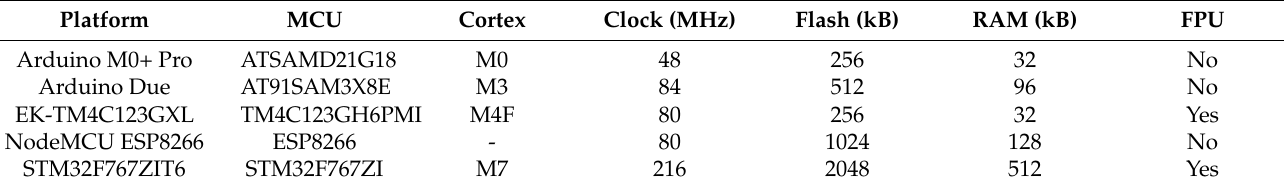
Table 1. Experimental tests platform